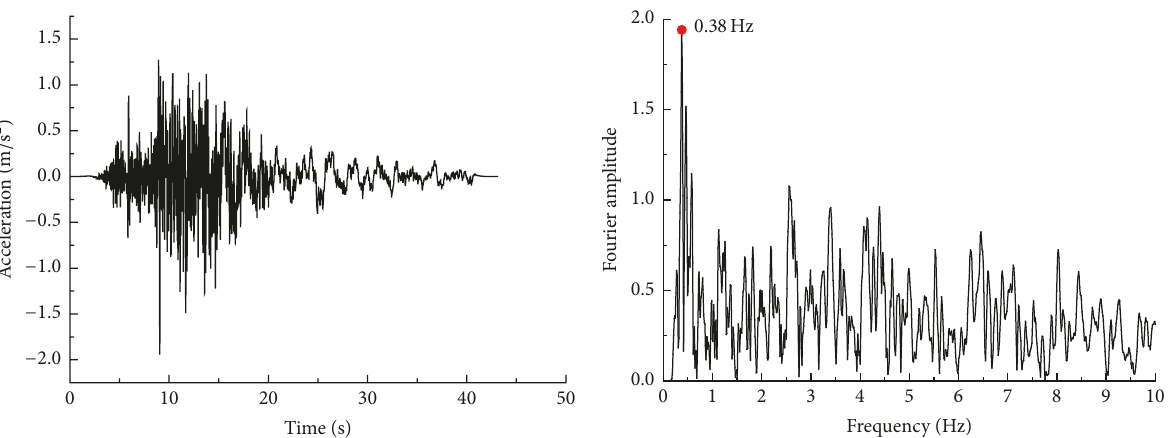
Figure 4: Seismic parameters of the Wolong earthquake waveform (EQ1).